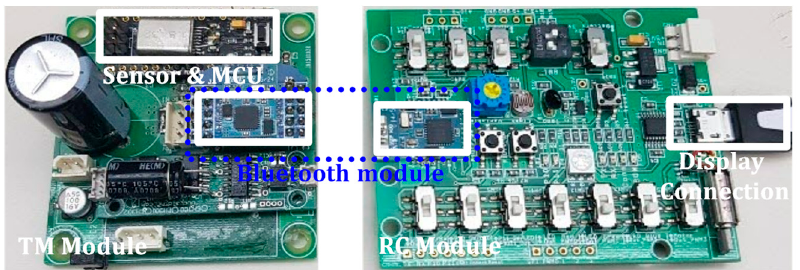
Figure 14. A low power Radio Frequency (RF) module with a Bluetooth module ( BoT-CLE100 ), temperature and humidity sensor ( HT01DL ), and MCU ( atmega16L ).